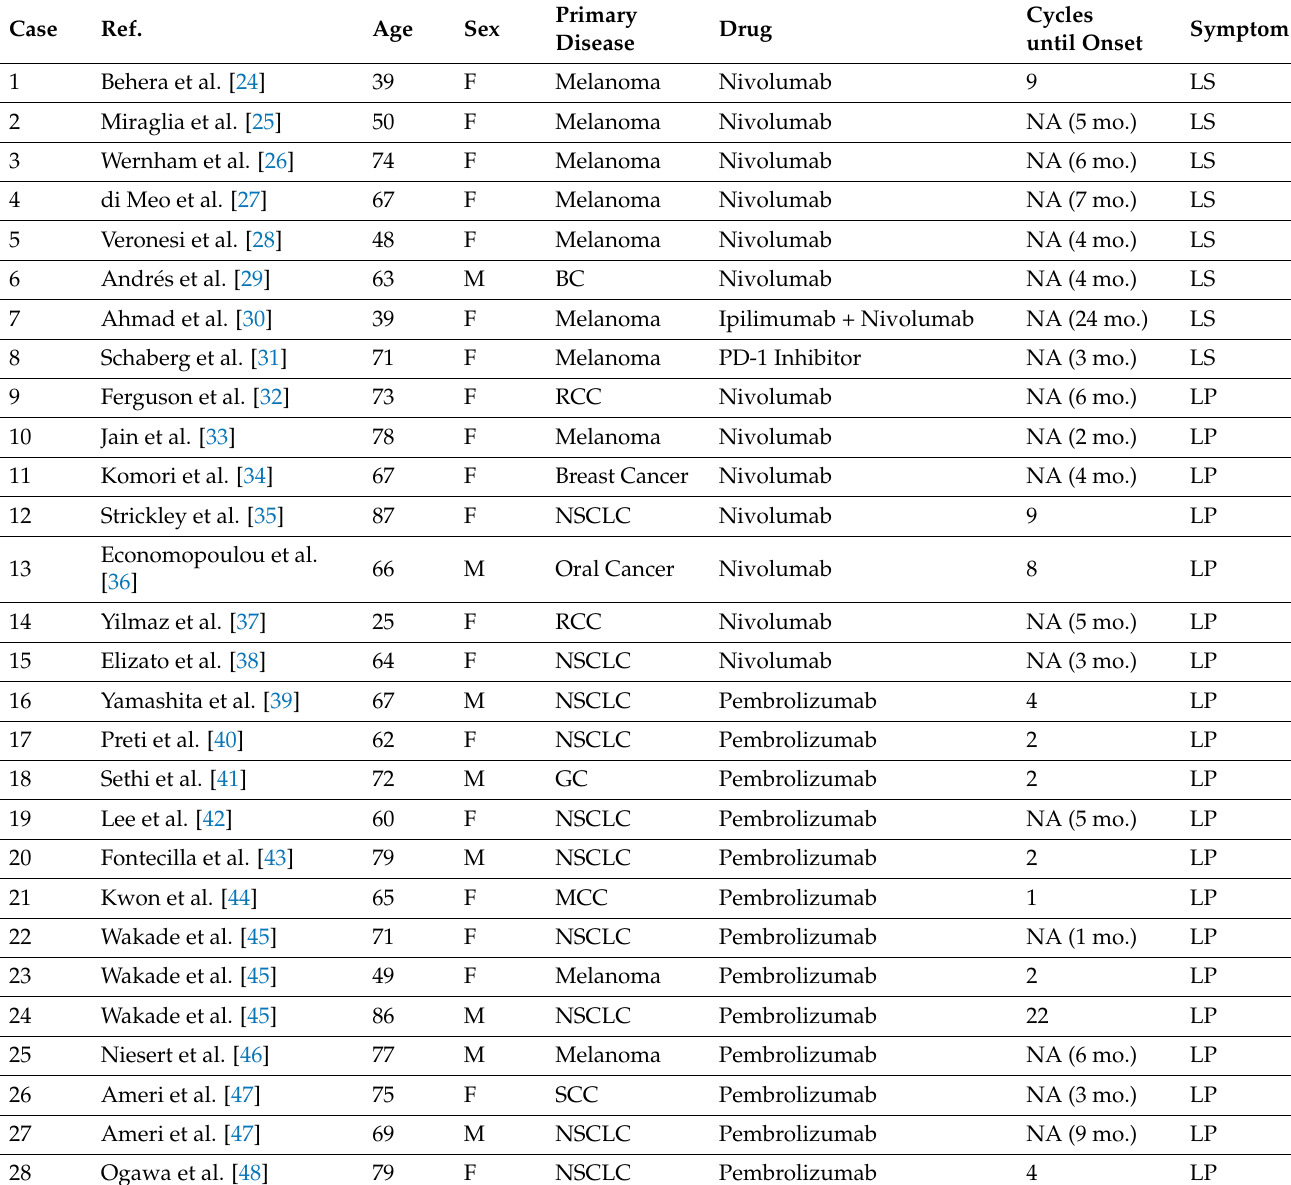
Table 1. Characteristics of cases with immune-checkpoint-inhibitor-related lichen sclerosus and lichen planus reported in the